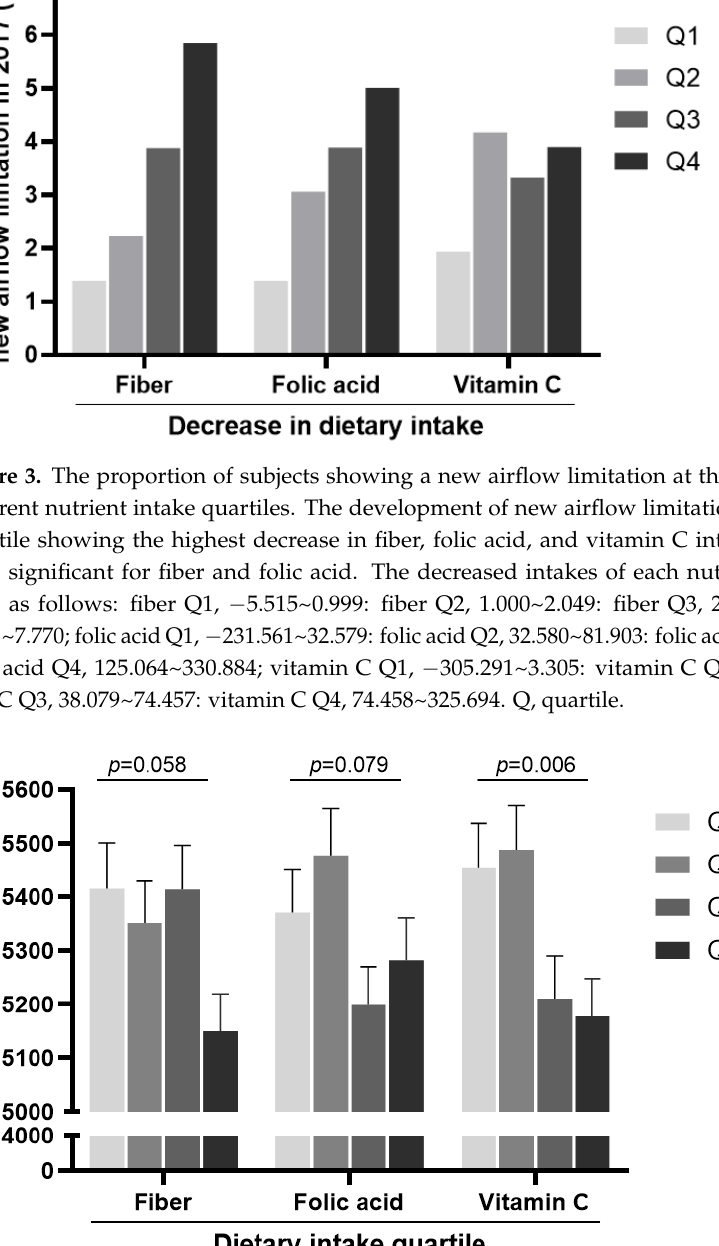
6 of 12 Figure 2. Association between new airflow limitation onset and nutrient intake differences between the baseline and 5- year follow-up. Adjusted for gender, age, smoking history, and FEV 1 /FVC at baseline (2012). ( A ) Unadjusted OR ( B ) Ad- justed ORs is added to the end of figure 2 title. All values are expressed with a 95% confidence interval. Only diet compo- sition with statistical significance in univariate analysis was selected. OR, odds ratio. To further examine the effects of changes in dietary fiber, folic acid, and vitamin C, these intake and changes were divided into quartiles and then compared with the onset of new airflow limitations. The proportion of new airflow limitation cases increased sig- nificantly with a higher reduction in the dietary intake of fiber (1.39% vs. 5.85% for quartile 1 vs. quartile 4, p = 0.005) and folic acid (1.67% vs. 5.01% for quartile 1 vs. quartile 4, p = 0.050) 5 years after baseline (Figure 3). In cross-sectional analysis in 2017, we found that a higher dietary vitamin C intake was associated with a lower onset of airflow limitation at the 5-year follow up with marginal significance (5.29% vs. 1.67% for quartile 1 vs. quartile 4, p = 0.059, Supplementary Figure S1). The WBC counts were lowest in the highest quar-